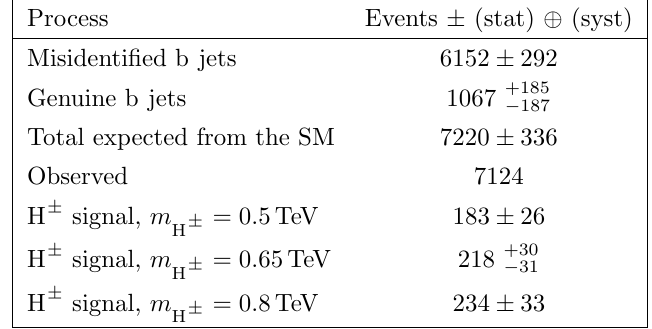
Table 3 . The numbers of expected and observed events for the resolved analysis after all selections. For background processes, the event yields and their corresponding uncertainties are prior to the background-only (cid:12)t to the data. For the H (cid:6) mass hypotheses of 0.50, 0.65, and 0.80 TeV, the signal yields are normalized to a (cid:27) B = 1 pb and the total systematic uncertainties prior to the (cid:12)t are shown.